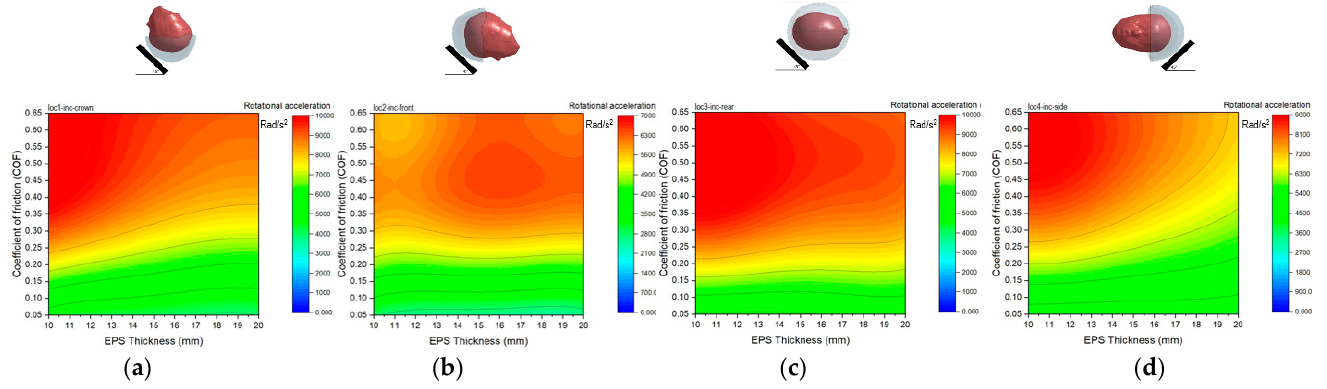
Figure 15. Relationship between helmet parameters and the rotational acceleration predicted by the ROM with the inclined anvil drop test at ( a ) crown, ( b ) front, ( c ) rear, and ( d ) side impact locations. Table 5. Suggested ranges of a suitable friction coefficient and liner thickness.